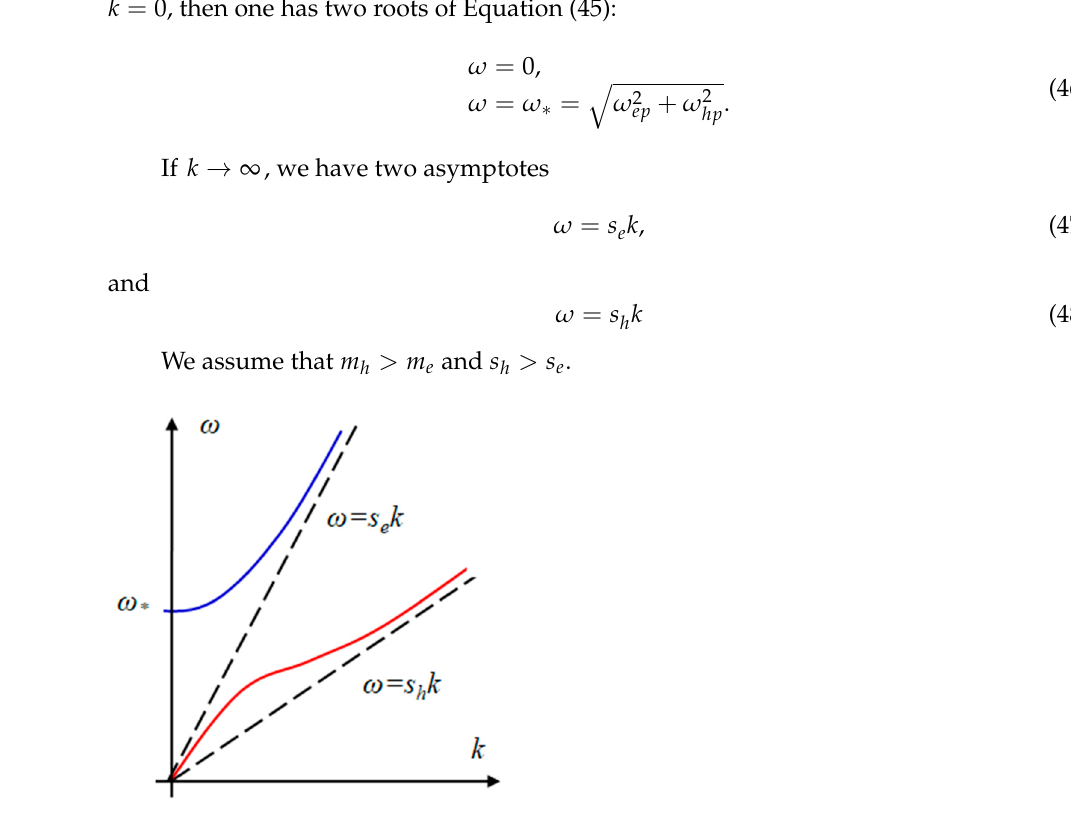
Figure 2. The schematic plots of dispersion curves for sound waves in the electron-hole fluid. The upper curve corresponds to the electron sound, while the lower curve corresponds to the hole sound. The group velocity of hole sound in the long wave limit ( k → 0)